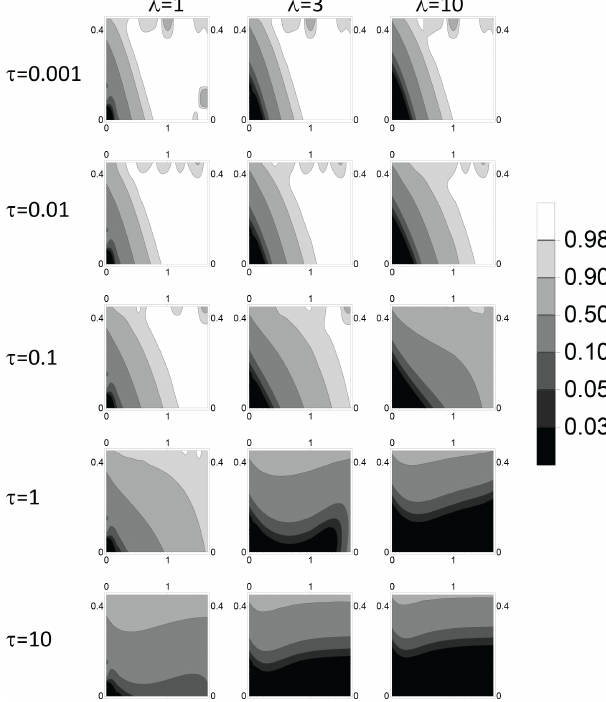
Figure 16. Contour plots of the forecast skill, with h along the hori- zontal axis and α along the vertical axis. The plots are for increasing nondimensional resolutions: τ = 0 . 001, 0.01, 0.1, 1, and 10 (top to bottom), with forecasts for lags λ = 1, 3, and 10 (left to right) and with contour levels (legend) varying from nearly no skill (0.03) to nearly full skill